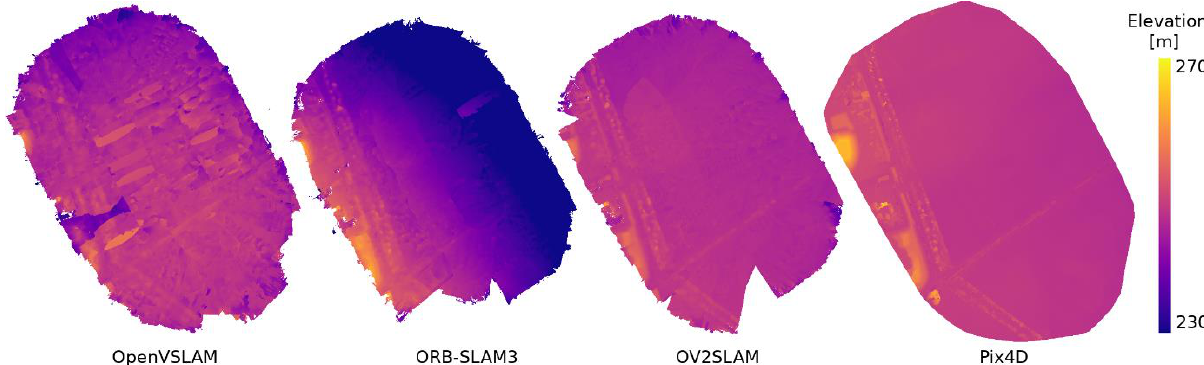
Figure 5 A visual comparison of digital surface models between the three SLAM-based real-time procedures and the reference data set processed with